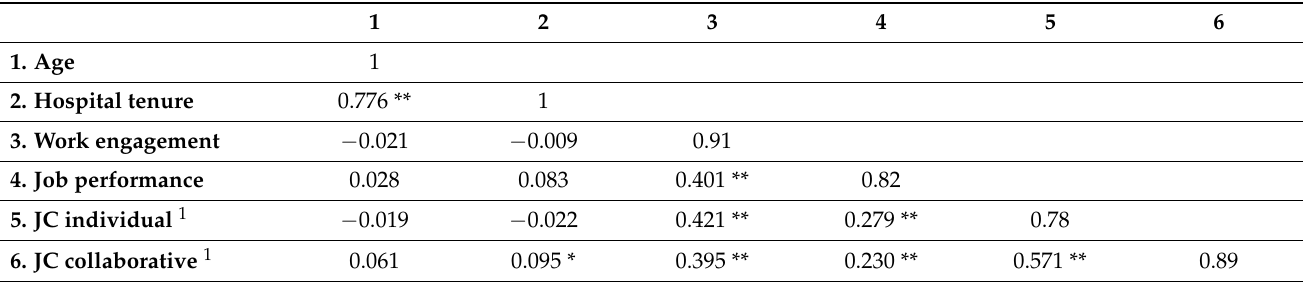
Table 3. Study 2 Pearson’s correlation matrix ( N = 498).